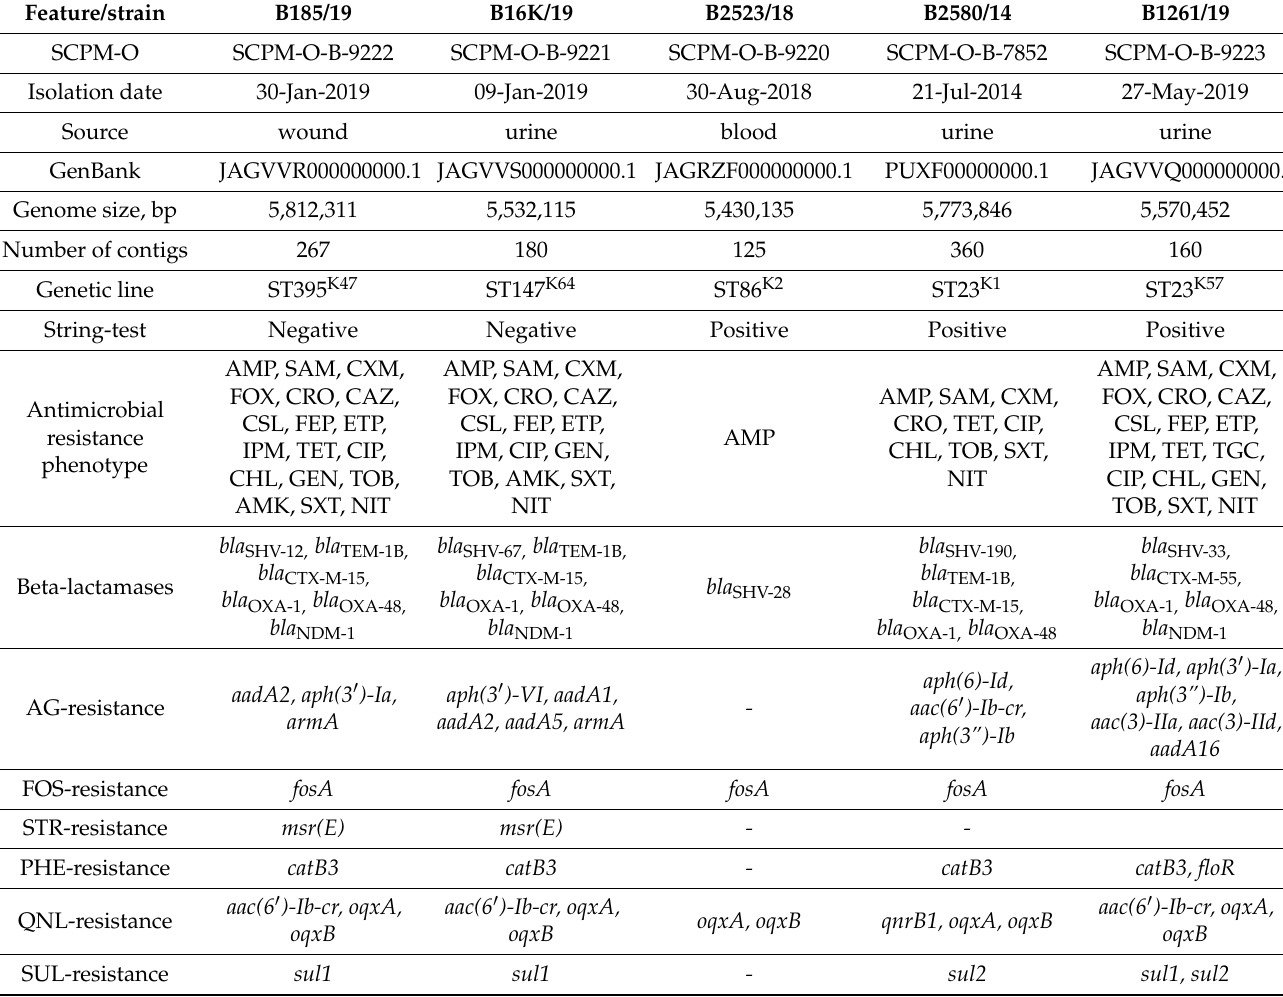
Table 1. Characteristics of K. pneumoniae strains used for whole-genome sequence